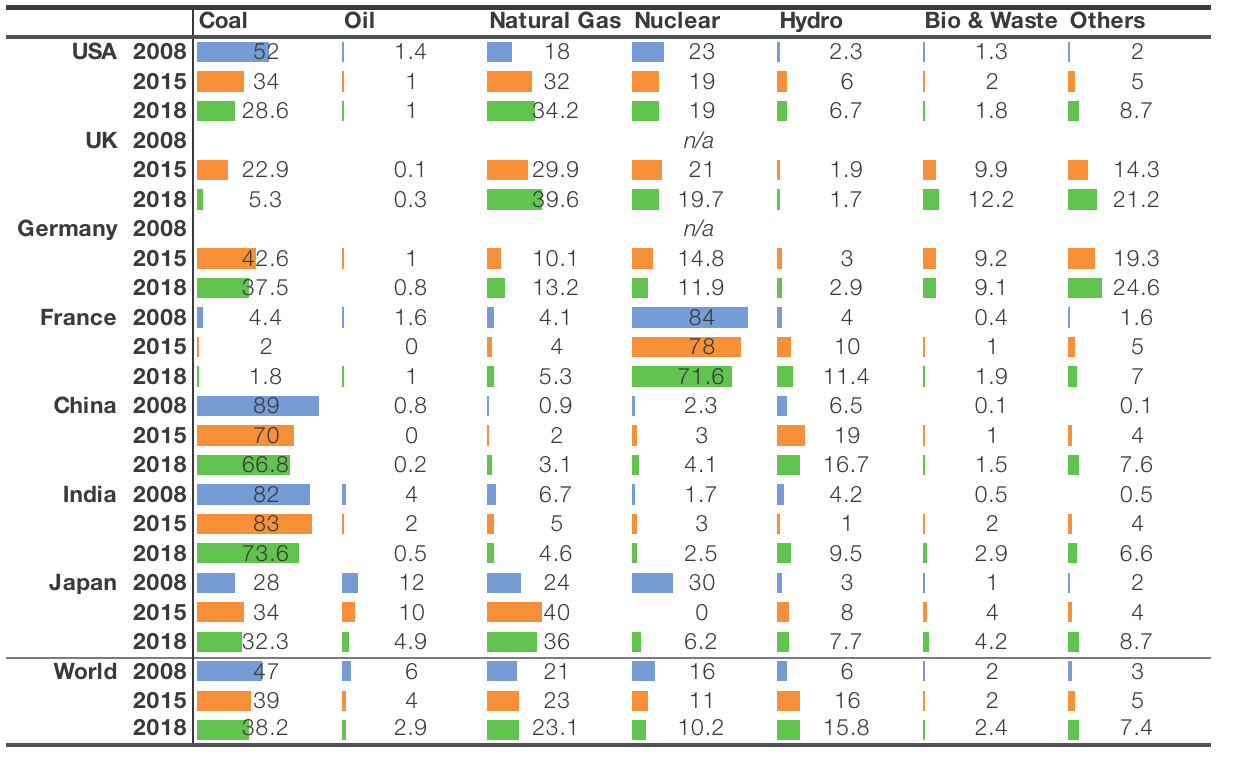
TABLE 1 | Electricity generation in 2008, 2015, and 2018 for eight regions, detailed by primary energy source [compiled from data in ANRE (2011), EDMC (2011, 2018, 2021)]. Coal